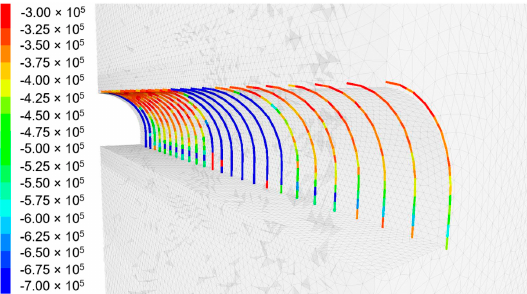
Figure 14. Axial forces in the modelled supports, expressed in newtons, variant I with a variability coefficient of 25%.